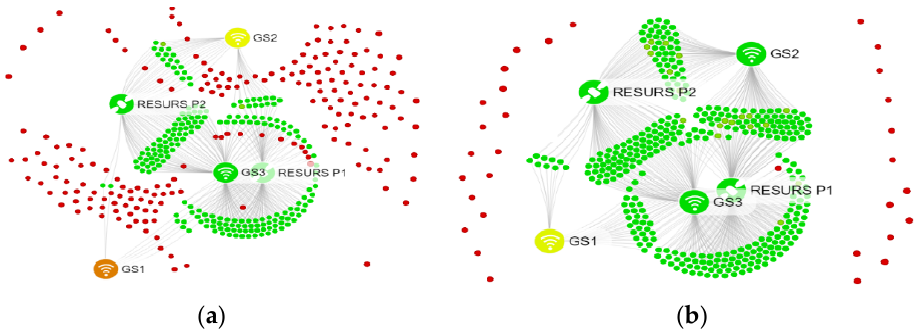
Figure 10. Examples of screens of the toolset: ( a ) initial state where many new orders (red circles) are not allocated to satellites (RESOURCE) and ground stations (GS); ( b ) the final state of consensus where only few red orders are still not scheduled.